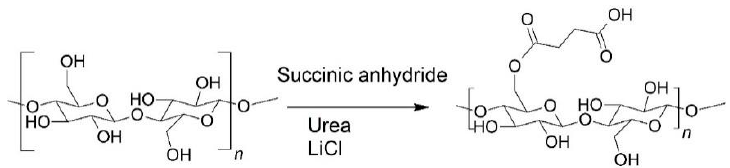
Figure 3. Succinylation reaction of cellulose in urea-LiCl DES.